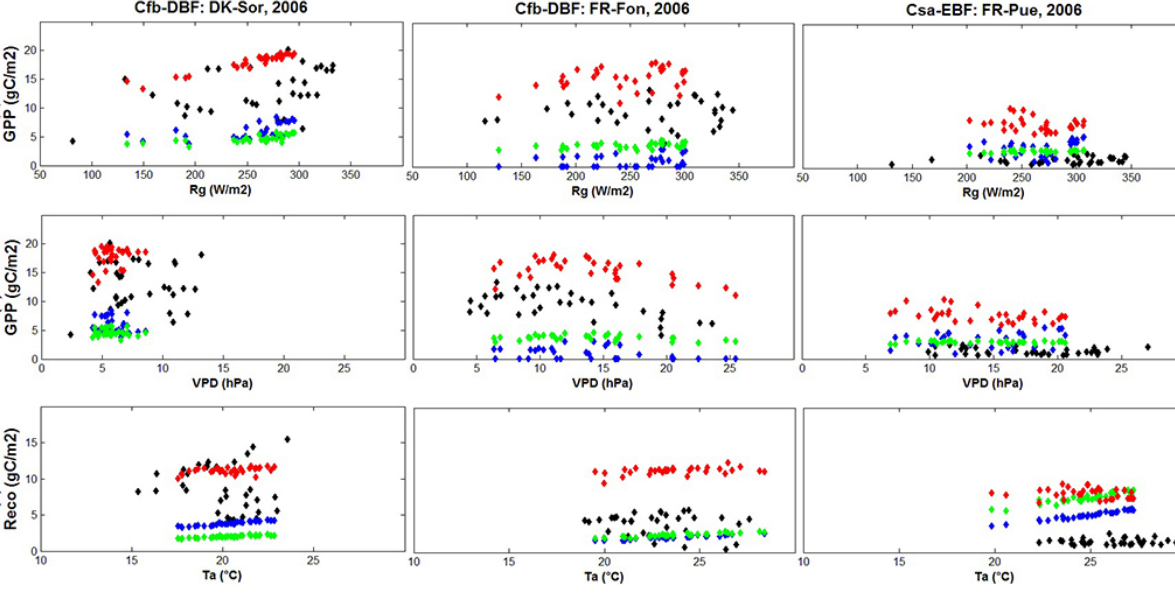
Figure 7. GPP response curves to (a) global radiation ( R g ) and to (b) VPD; and Reco response curve to (c) air temperature ( T a ) for three forest sites (DK-Sor, FR-Fon and FR-Pue) in 2006. ISBA-A-gs model simulation is in blue, CTESSEL in green and ORCHIDEE in red, while black line represents EC measured